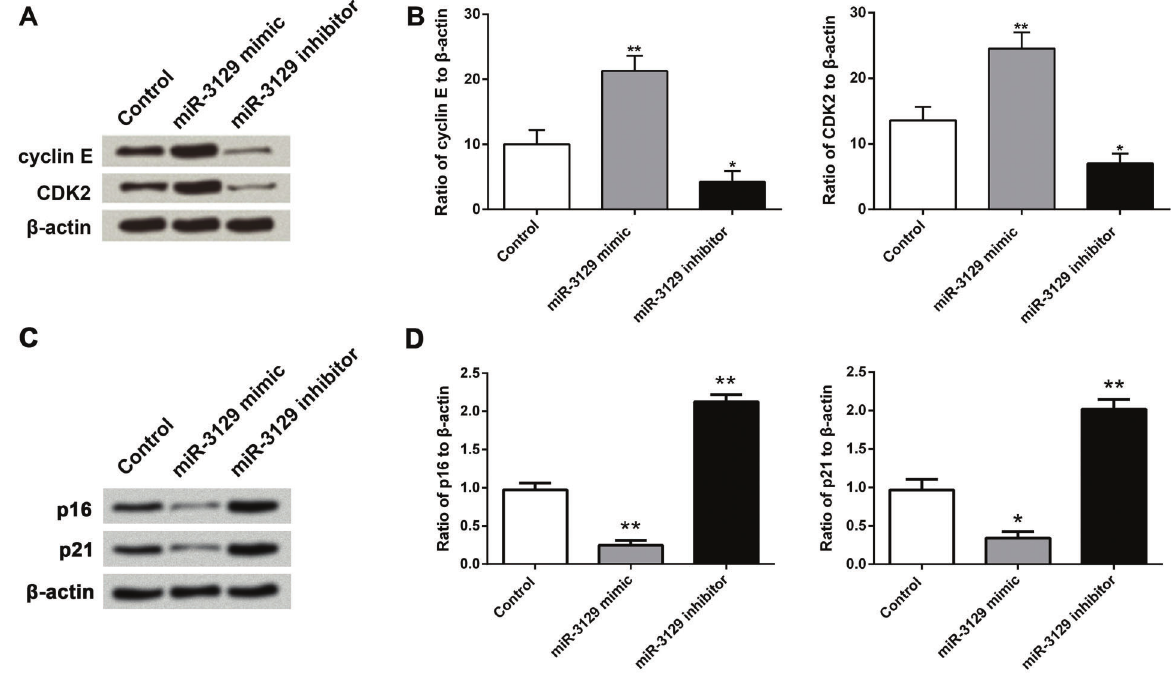
Figure 4. Effects of miR-3129 on cyclin E and CDK2 expression in SGC7901 miR-transfected cells. A , Western blotting was performed to assess the expression of cyclin E and CDK2. B , RT-qPCR was performed to assess the expression of cyclin E and CDK2. C , Western blotting was performed to assess the expression of p16 and 21. D , RT-qPCR was performed to assess the expression of p16 and 21. CDK: cyclin dependent kinase; RT-qPCR: quantitative real time polymerase chain reaction. Data are reported as means ± SD. *P o 0.05, **P o 0.01 (ANOVA followed by Tukey post hoc